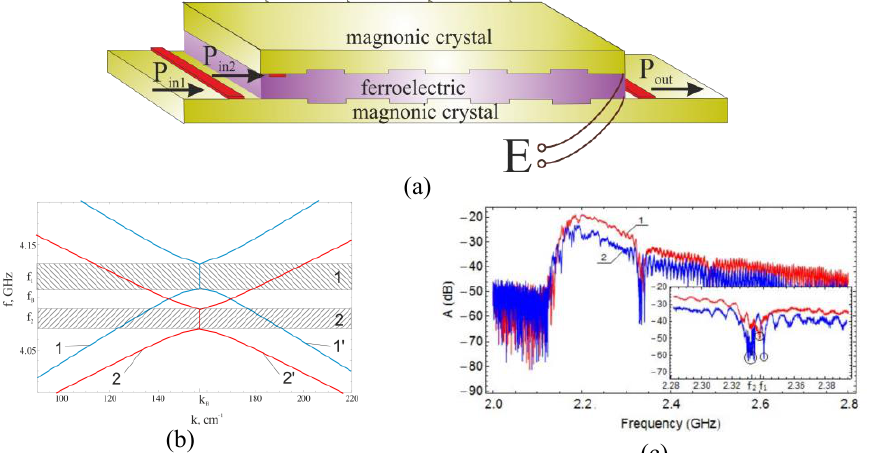
Fig. 1. (a) Scheme of investigated structure. (b) Dispersion charachteristics of surface magnetostatic waves in structure of coupled magnonic crystals, that are the films of Yttrium Iron Garnet with a periodic system of grooves on the [4] (c) Spectra of surface magnetostatic waves in structure of coupled magnonic crystals when signal is applied to both magnonic crystals (red curve 1), to one magnonic crystal (blue curve 2)